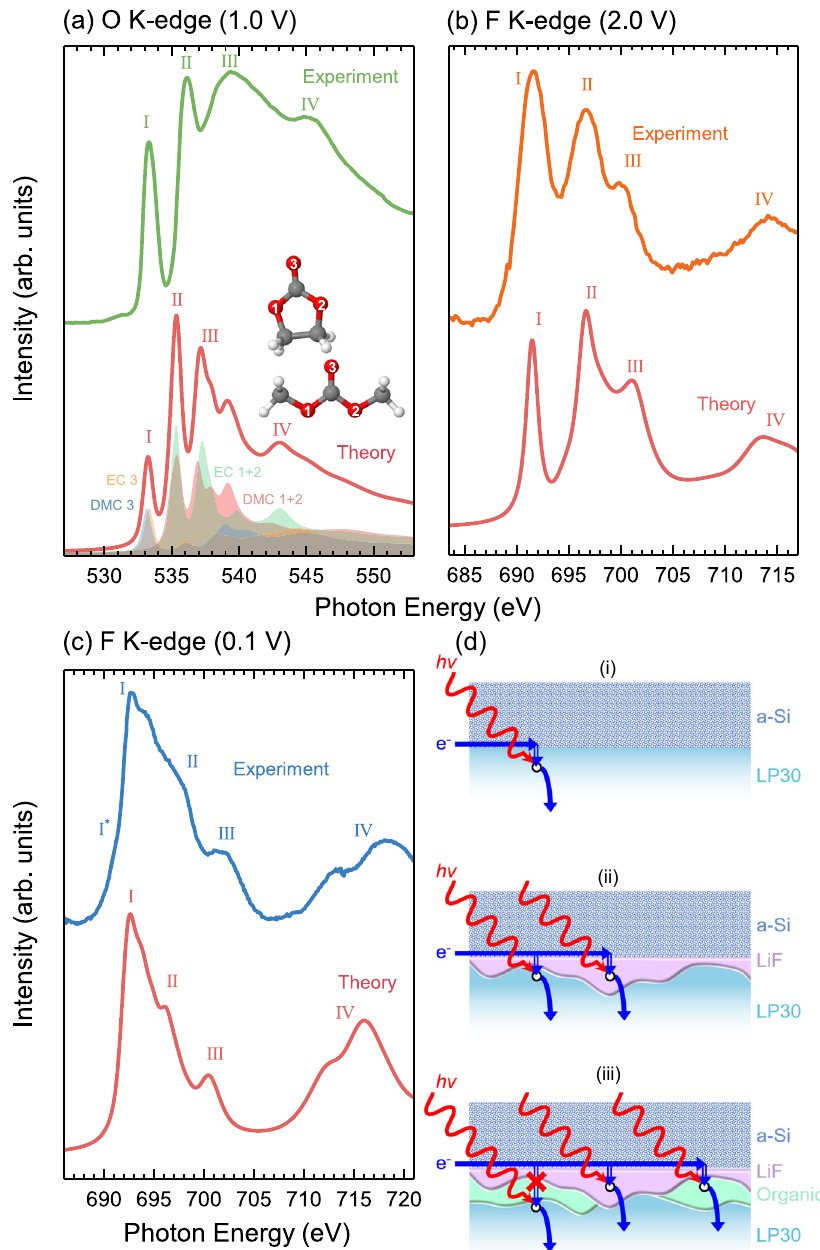
Fig.4|SimulatedandexperimentalX-rayabsorptionspectra.a OK-edgeforthe theadditionofECandDMCisolatedmolecules(bottom)andtheexperimentaldata (top)recordedat1Vbias. b FK-edgesimulatedforanLiPF 6 in fi nitecrystal(bottom) and experimental data (top) recorded at 2.0V bias. c F K-edge simulated for a LiF